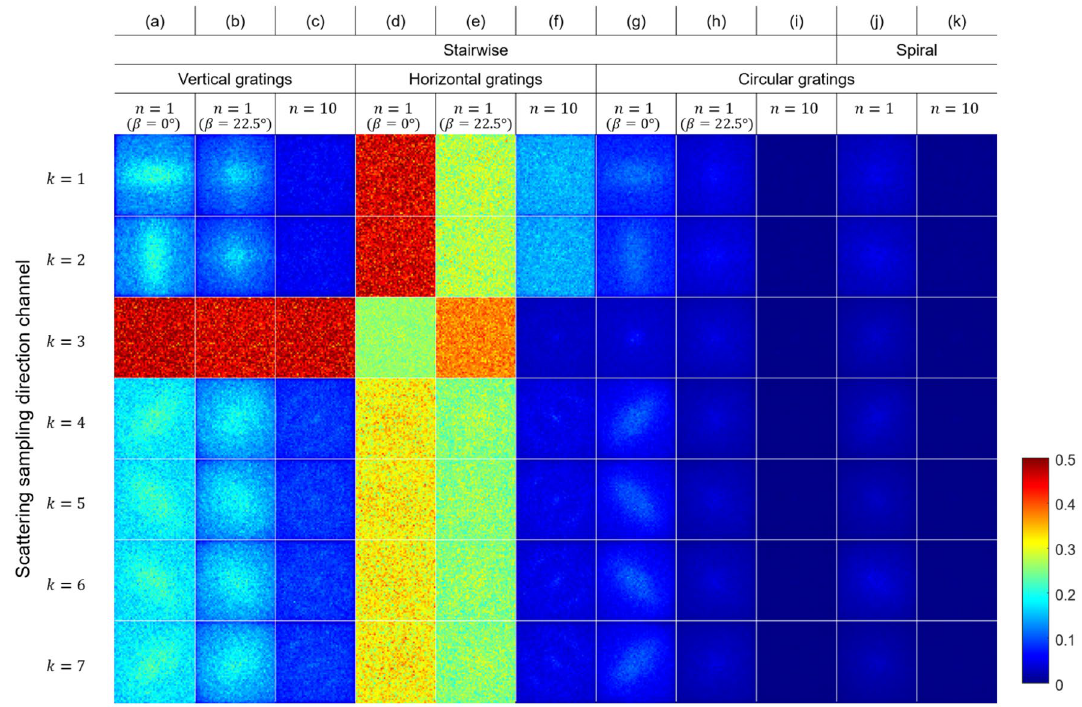
Figure 3. Visualisation of the computed null space for different scattering sampling directions k . The null space was computed for different acquisition geometries: stairwise and spiral acquisition; different grating types: vertically aligned linear gratings, horizontally aligned linear gratings, and circular gratings; different number of turns n . β indicates the tilt angle. High values in null space for scattering component k indicate that the acquisition protocol provides large uncertainties in the reconstruction for that